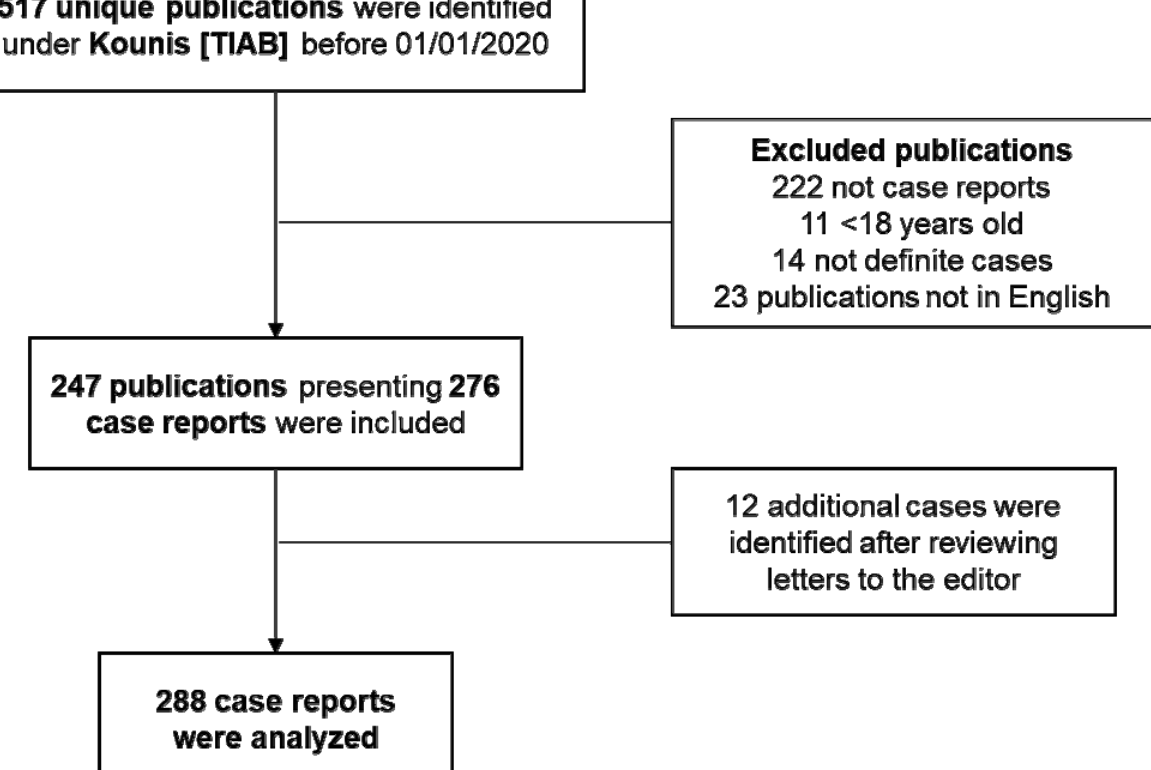
Figure 1. Flowchart showing the selection process for the included papers and exclusion criteria.